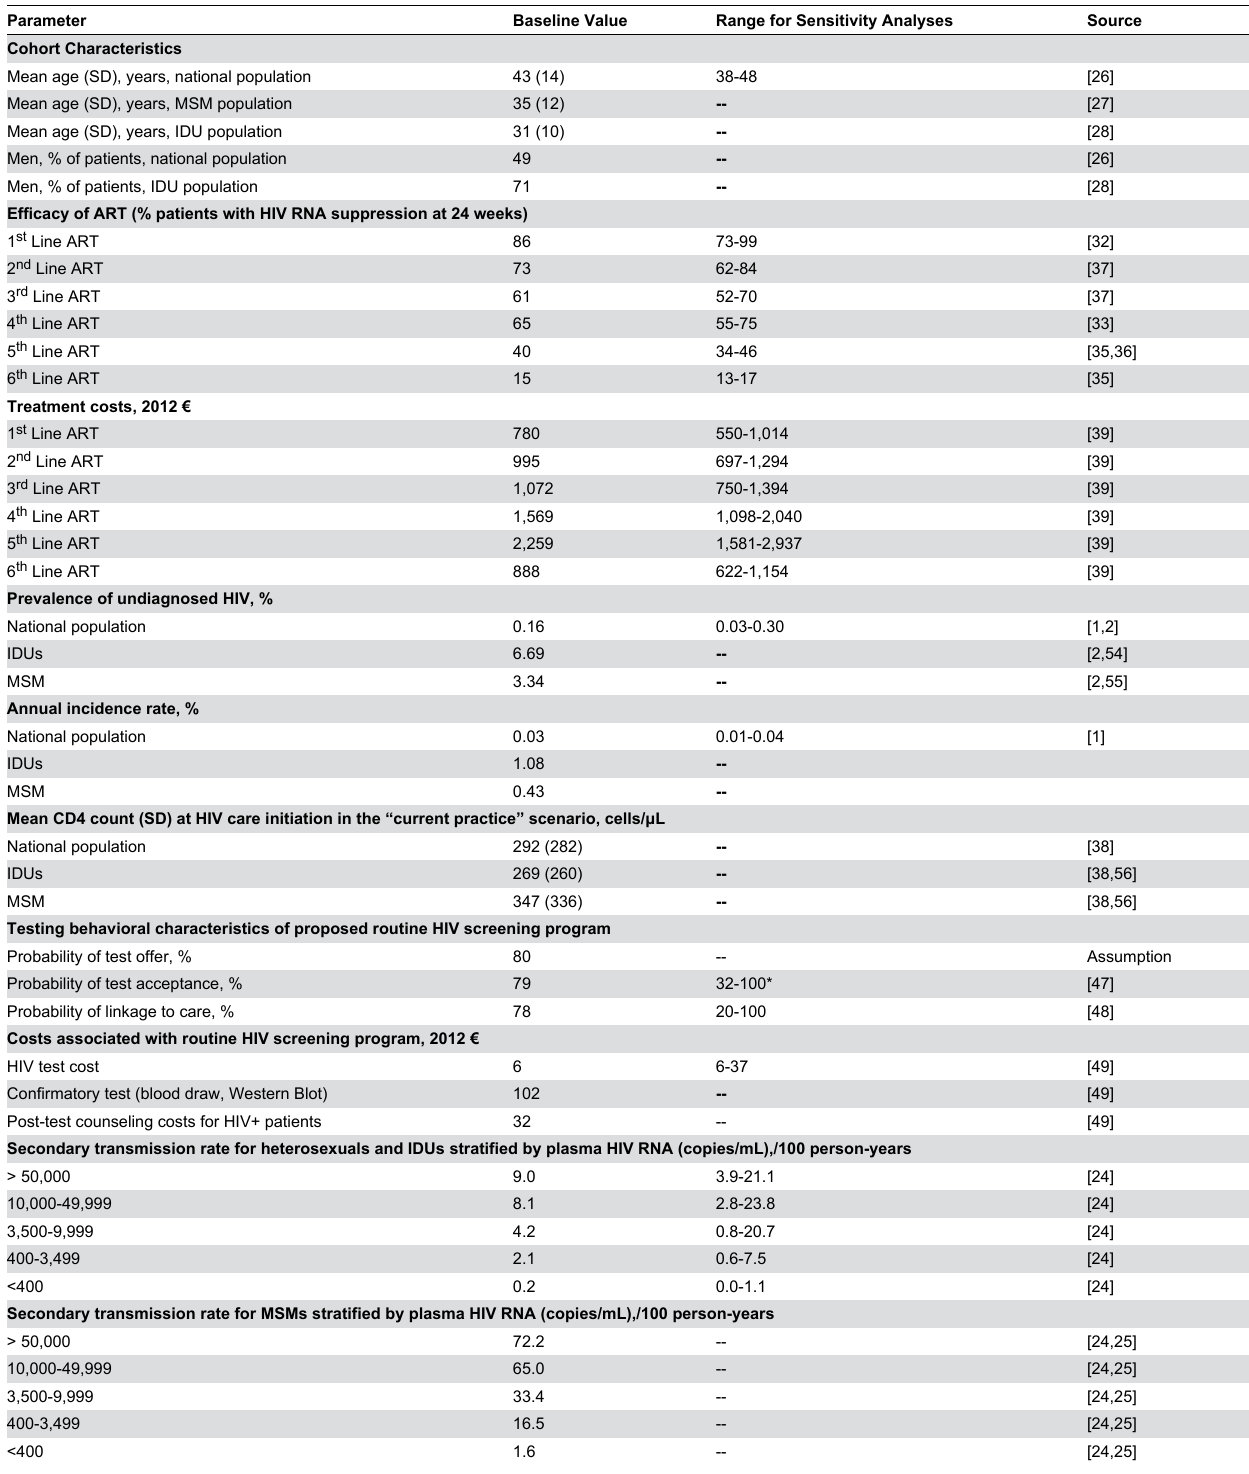
Table 1. Input Parameters for a Model of Routine HIV Screening in